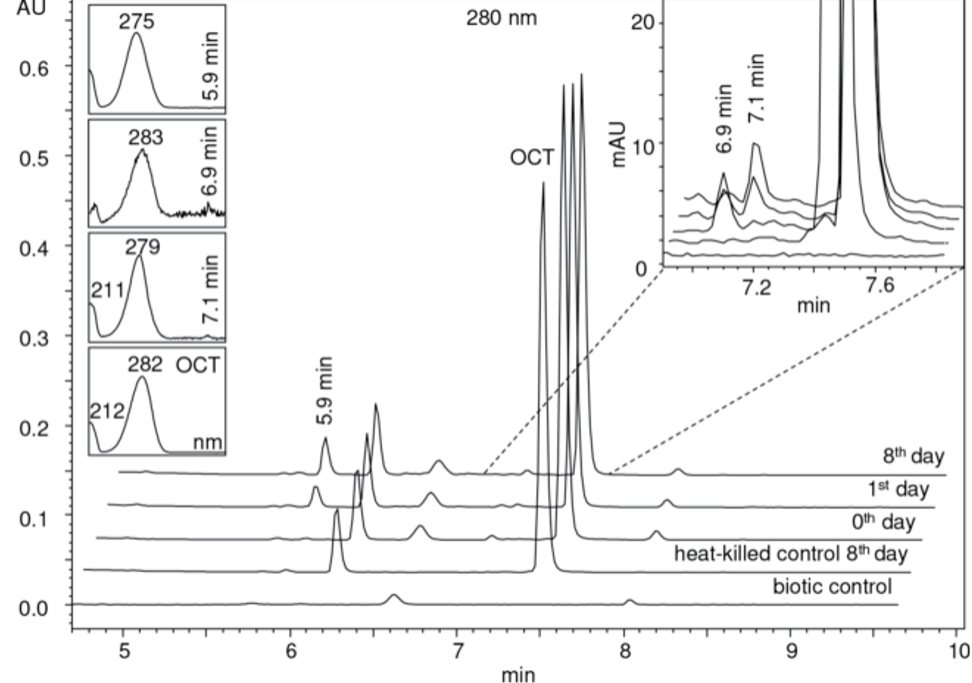
Figure 5. LC-UV plots of degradation samples acquired during in vitro octenidine (OCT) degradation in the concentrated extracellular liquid of I. lacteus supplemented with Mn 2+ and H 2 O 2 . The UV absorption spectra of specific peaks are given in the insets.